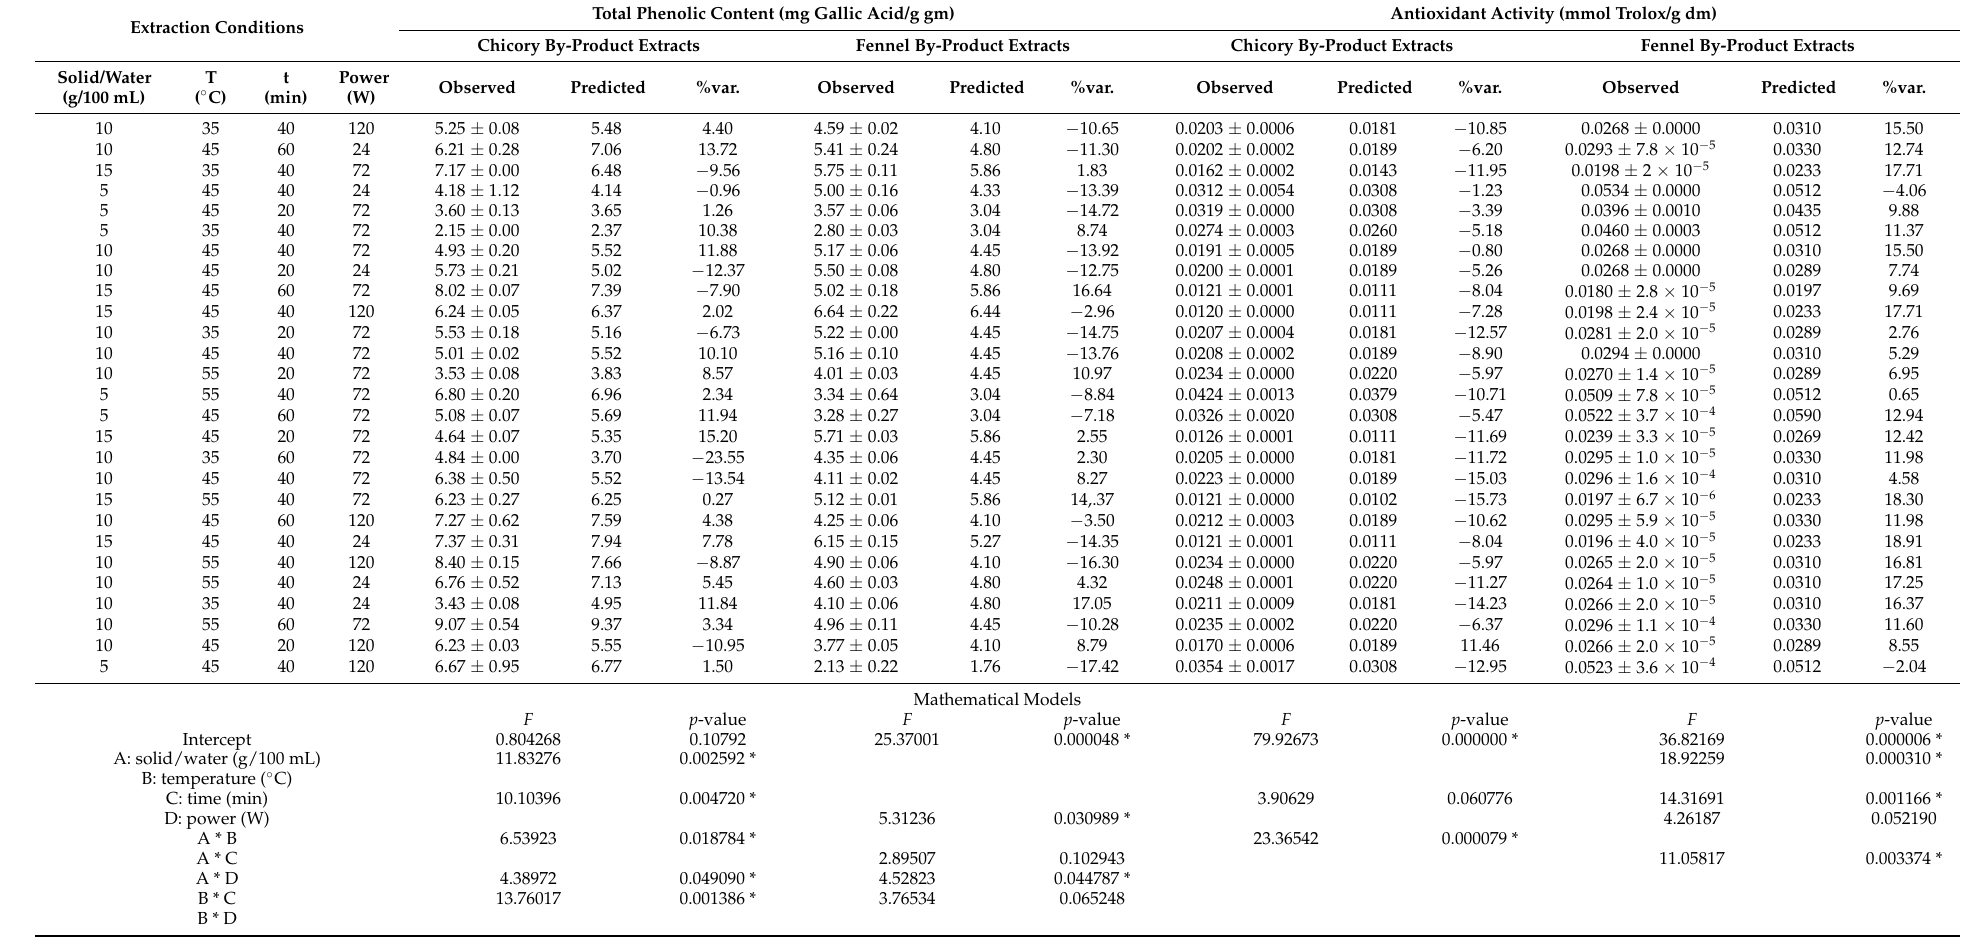
Table 2. Development of the Box–Behnken experimental design for ultrasound-assisted extraction: experimental results (observed) and values predicted by the models for total phenolic content and antioxidant activity; analyses of variance for linear, quadratic, and interactive effects of the independent variables and the determination coefficients of the